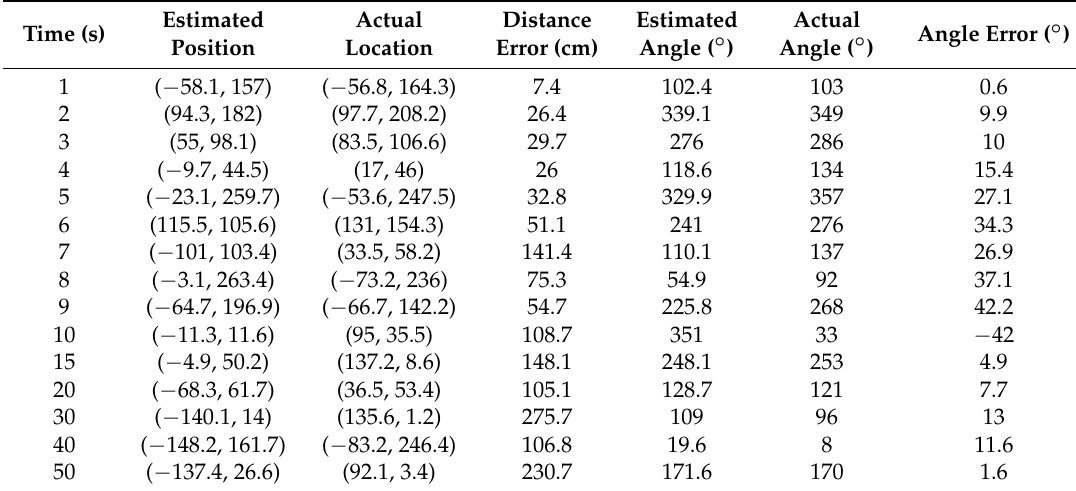
Table 9. Comparison without Six-Axis Sensors.